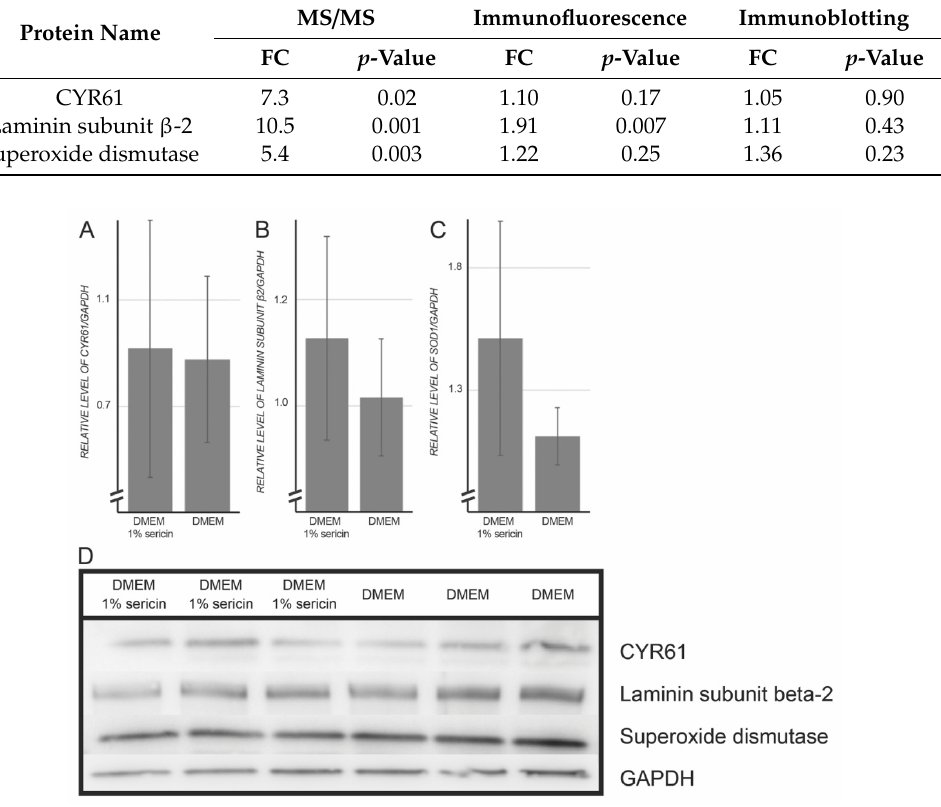
Figure 3. Whole-cell lysates of human retinal pigment epithelial cells (RPE) cultured for seven days in Dulbecco’s Modified Eagle’s Medium (DMEM) with or without 1% sericin were subjected to Western blot experiments. Glyceraldehyde 3-phosphate dehydrogenase (GAPDH) was used as loading control. Fold change (FC) was calculated as follows: FC = ((mean of protein expressions in RPE cultured in DMEM with 1% sericin)/(mean of protein expressions in RPE cultured in DMEM without sericin)). ( A ) Cysteine-rich angiogenic inducer 61 (CYR61); FC: 1.05; p -value: 0.90. ( B ); Laminin subunit β -2; FC: 1.11; p -value: 0.43. ( C ) Superoxide dismutase; FC: 1.36; p -value: 0.23. ( D ) Western blot. Error bars represent standard deviation of the mean. N = 3.